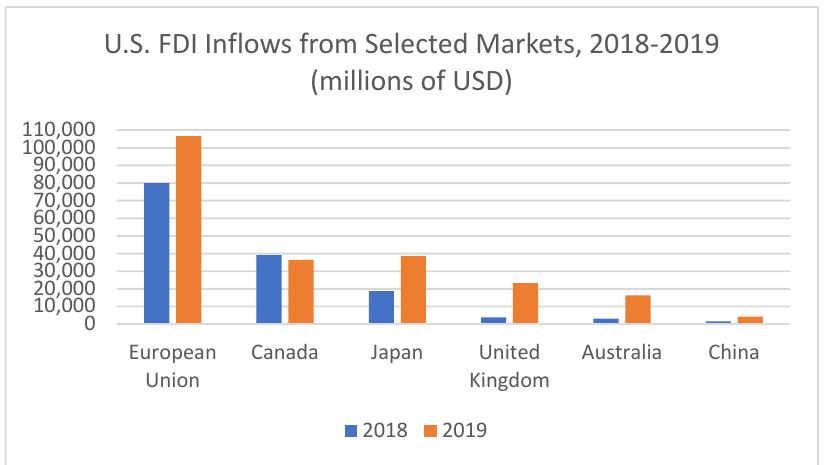
Figure 3. U.S. FDI Inflows from Selected Markets, 2018 – 2019 (millions of USD) (Data source: U.S. Bureau of Economic Analysis).